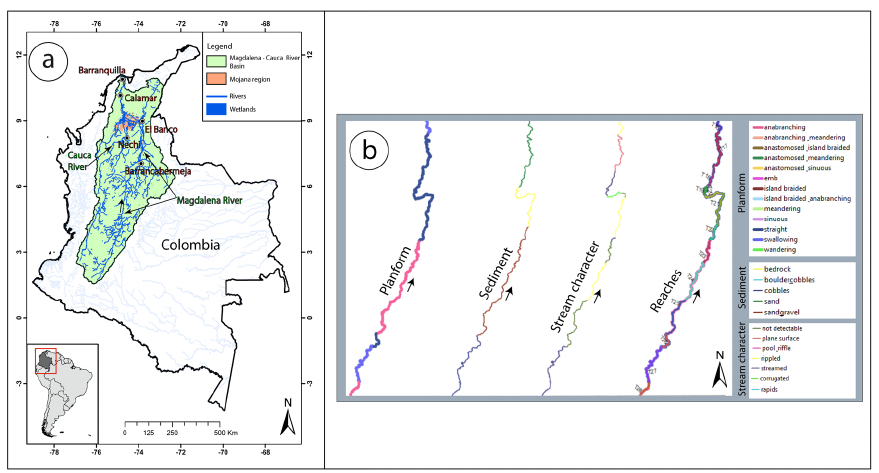
Figure 6. ( a ) location of the Magdalena River basin (Colombia); ( b ) Magdalena case study